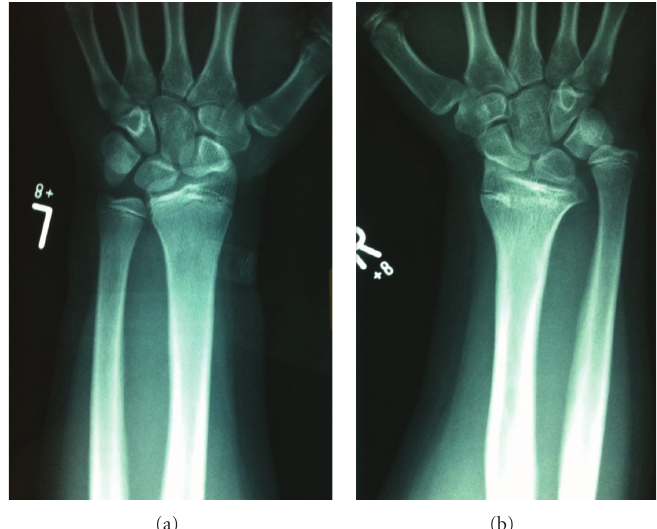
Figure 1: Bilateral anteroposterior radiographs of the distal radius demonstrating distal radius growth arrest on the right side compared to the normal left side.